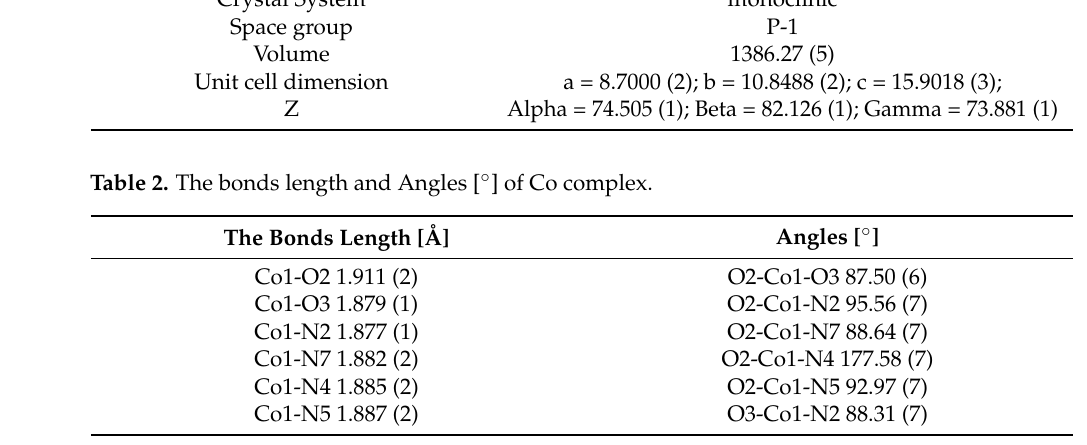
Figure 1. Octahedral geometry of Cobalt complex (left) and molecular structure of the complex com- Table 1. Crystal data and structure refinement details of compound 1 . pound 1 with the atom and ring-labeling scheme (right). Table 2. The bonds length and Angles [°] of Co complex. The Bonds Length [Å]